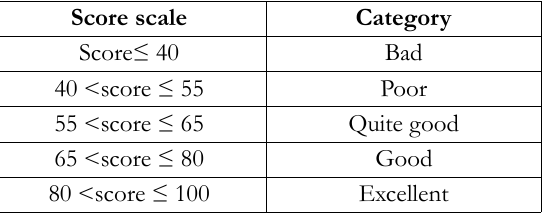
Table 3. SPS assessment criteria